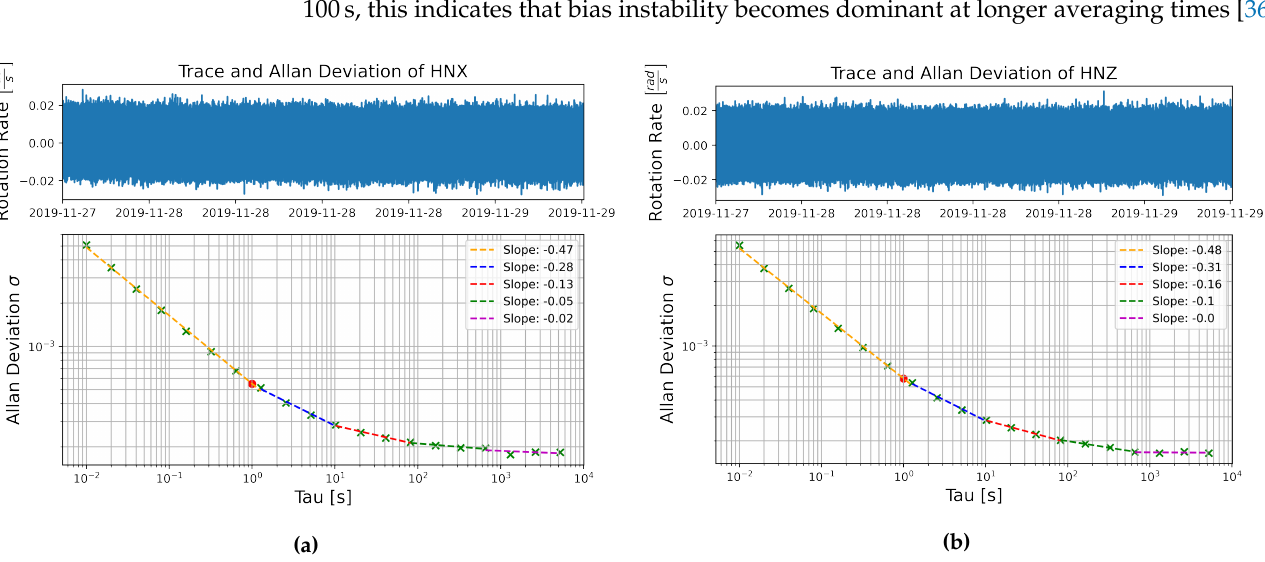
Figure 6. Allan deviation as a function of averaging time τ for self-noise recorded on the MEMS accelerometer components ( a ) HNX and ( b ) HNZ, data recorded in the basement test site between 27 November and 29 November